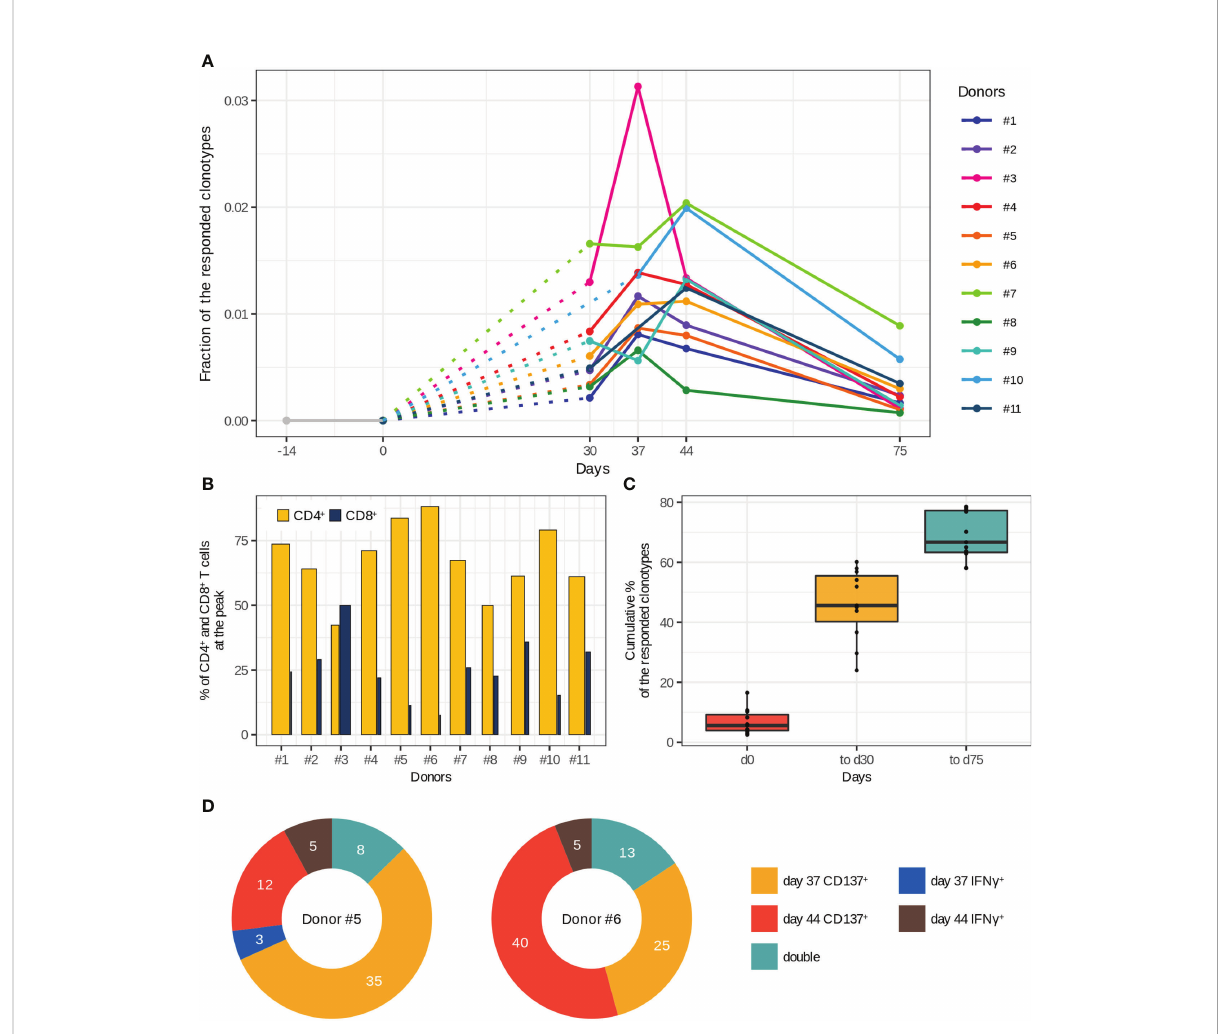
FIGURE 2 Characteristics of T cell immune response to two-step immunization with the inactivated TBE vaccine. (A) Dynamics of responded clonotype fractions in the bulk TCR b repertoire calculated as the sum of clonotype frequencies (average of two replicates at each time point). (B) Percentage of CD4 + and CD8 + T cells from the fraction of responded T cells at the peak of expansion. The bar width corresponds to the CD4 + or CD8 + T cell clones. (C) Cumulative percentage of responded clonotypes found in TCR b repertoires of memory (CD45RO + ) T cell subsets among the responded clonotypes. (D) Vaccine-associated clonotypes found in TCR b repertoires of CD137 + and IFN g -producing T cells obtained after in vitro stimulation with inactivated puri fi ed TBEV particles on days 37 and 44 for donors #5 and #6. The numbers of detected clonotypes are indicated. For more details about the detection of “ double ” clonotypes in the activated T cell subsets see Supplementary Figure